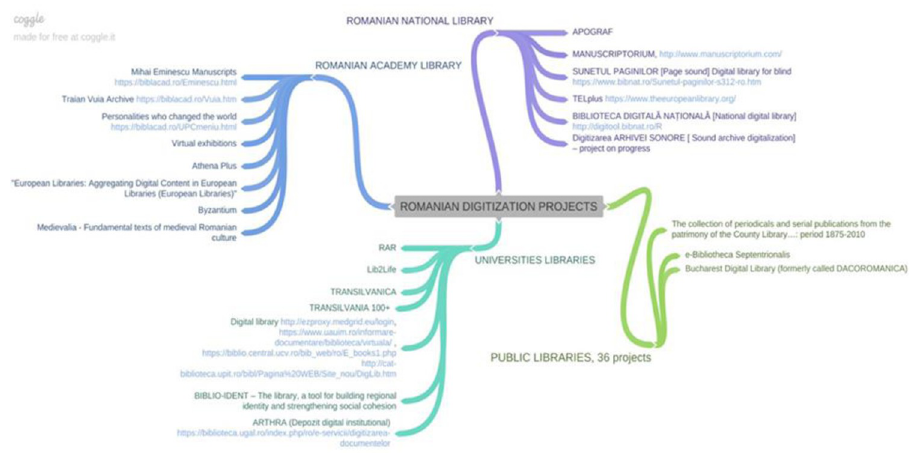
Fig 6. Romanian digitisation projects of own